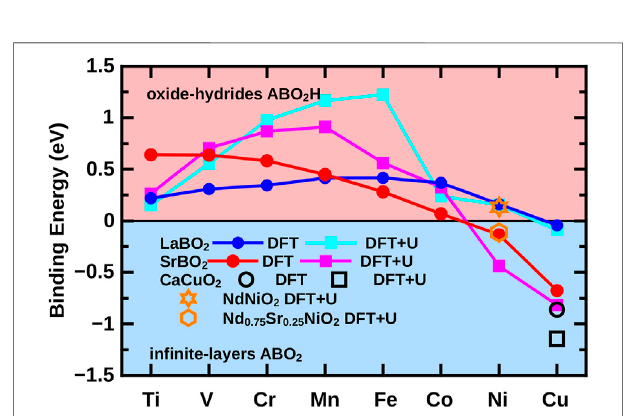
FIGURE 9 | DFT (white lines) and DMFT (color bar) k -resolved spectral